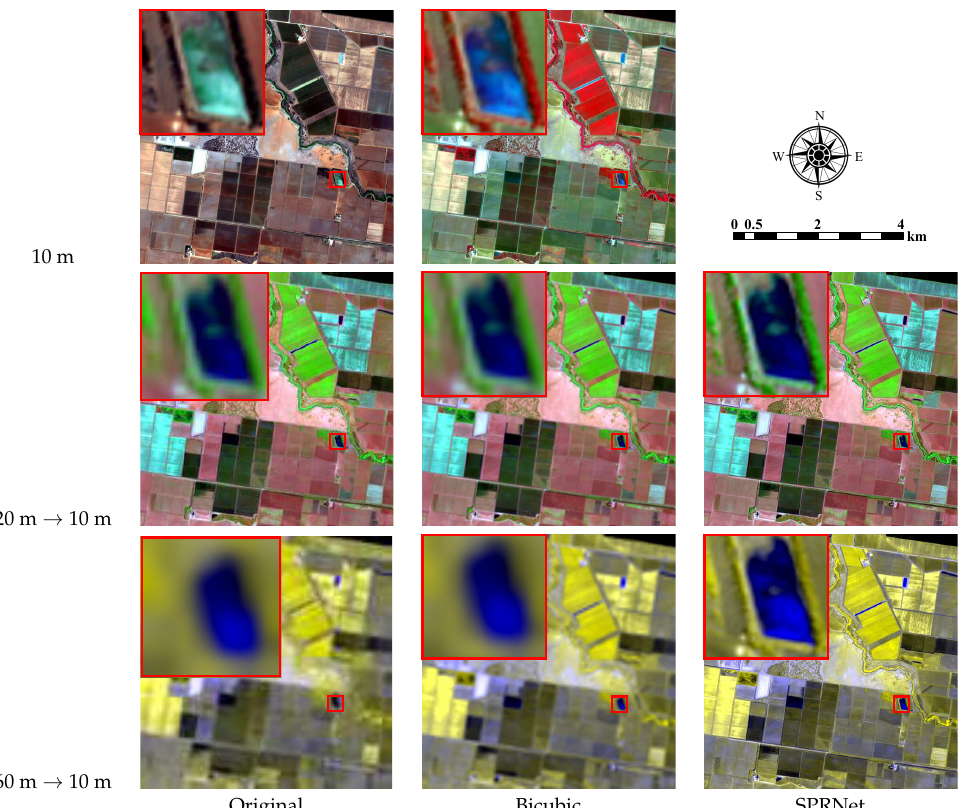
Figure 11. Visual results on real Sentinel-2 data on site 2. 10 m: true RGB (B2, B3, B4) and false RGB (B8, B4, B3). 20 m (B12, B8a and B5 as RGB): original image, up-scaled result to 10 m with bicubic, and sharpening result to 10 m with SPRNet. 60 m (B9, B9 and B1 as RGB): original image, up-scaled result to 10 m with Bicubic, and sharpening result to 10 m with